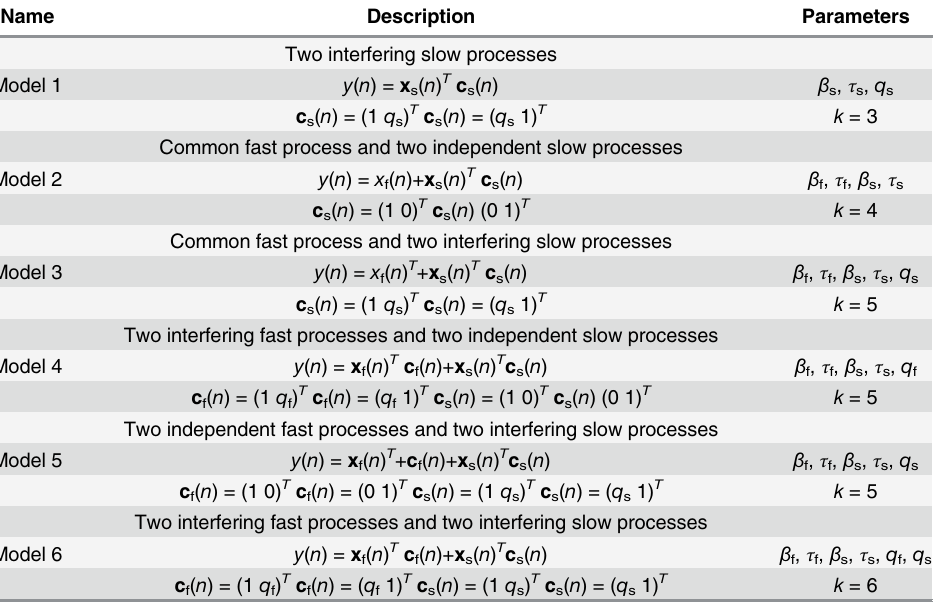
Table 1. Description of tested models. Each of candidate models was fitted to all the data from the three groups ( N = 300). For the groups with one task, SHORT-ITI and LONG-ITI, the interference parameters were ignored in